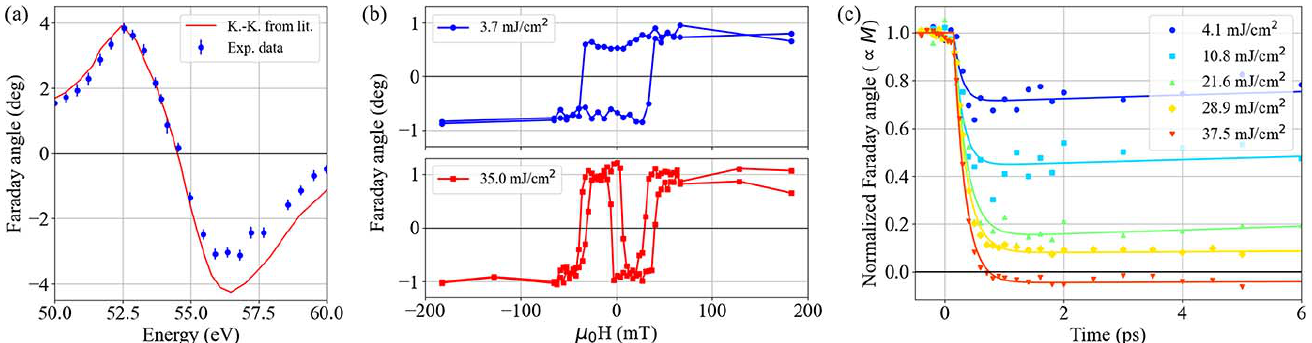
Figure 5 ( a ) Energy scan performed on the FeGd thin film around the Fe M 2,3 -edge. The Faraday angle is measured between opposite saturation states, to be directly compared with the hysteresis loop amplitude. The red line shows data taken from von Korff Schmising et al. (2020) and extracted from magnetic circular dichroism measurements via a Kramers-Kronig calculation. ( b ) Hysteresis loops measured at 53.9 eV for two different probing fluences. The experimental points have been obtained by fitting the polar profiles according to equation (3) and by removing from each loop its average value. ( c ) Delay scans measured at 52.8 eV for increasing pump fluences. The curve corresponding to the highest fluence shows magnetization inversion. The solid lines are fits performed according to equation